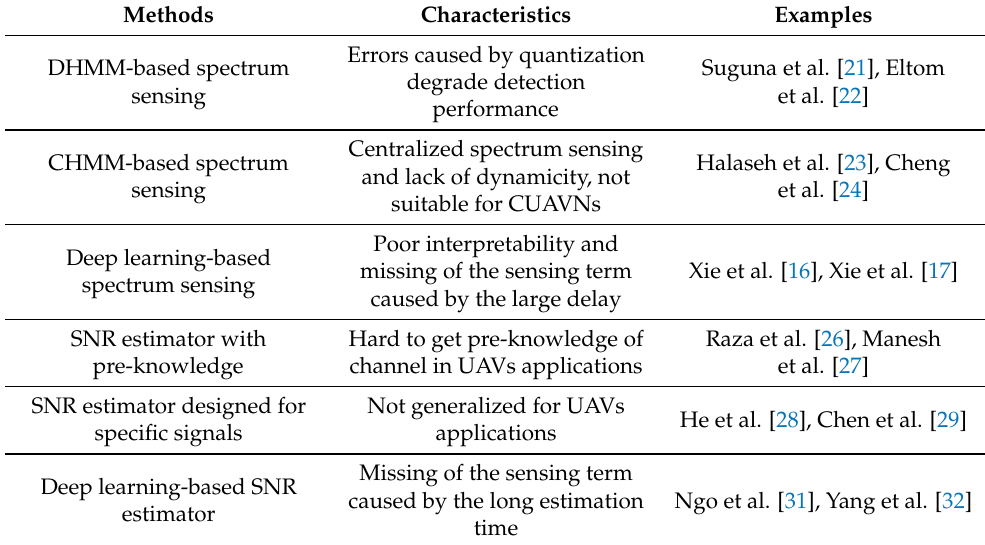
Table 2. The characteristics of the existing